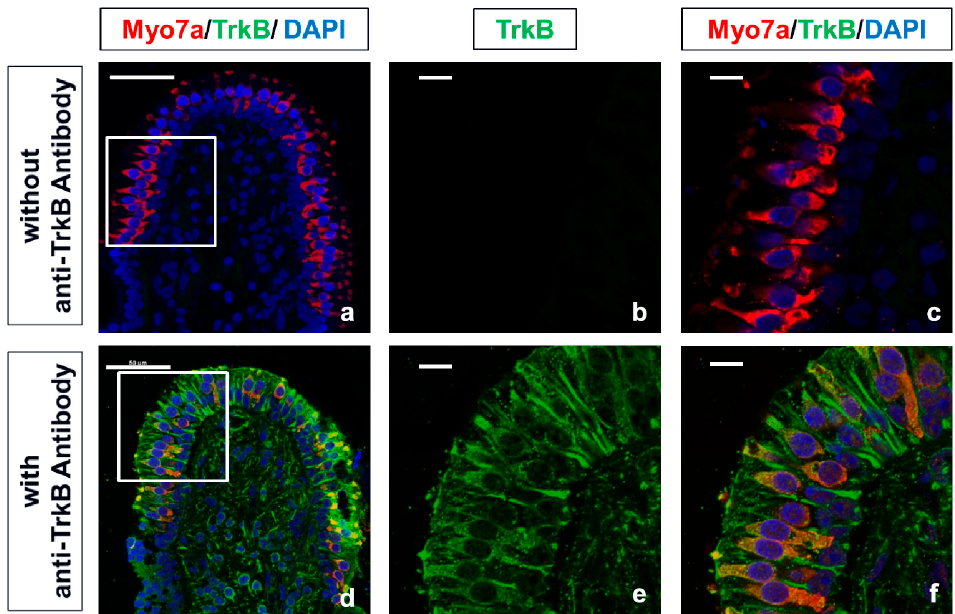
Figure 3. Confirmation of the TrkB receptor expression in crista ampullaris. ( a – c ) Upper panels are negative controls immunostained without the anti–TrkB antibody. ( d – f ) Lower panels show immunostaining with anti-TrkB antibody. Each middle and right panel ( b , c , e , f ) magnifies the boxed area in the respective left panel ( a , d ). Red represents MYO7A–labeled HCs, green represents TrkB receptors, and blue represents DAPI-labeled nuclei of cells. Expression of the TrkB receptor is confirmed in the cytoplasm of HCs and the peripheral region of the ampullary nerves. Scale bars ( a , d ), 50 µm; ( b , c , e , f ), 10 µm; DAPI, 4 ′ , 6-diamino-2-phenylindole; HC, hair cell; MYO7A, myosin 7a; TrkB, tropomyosin–receptor–kinase B.